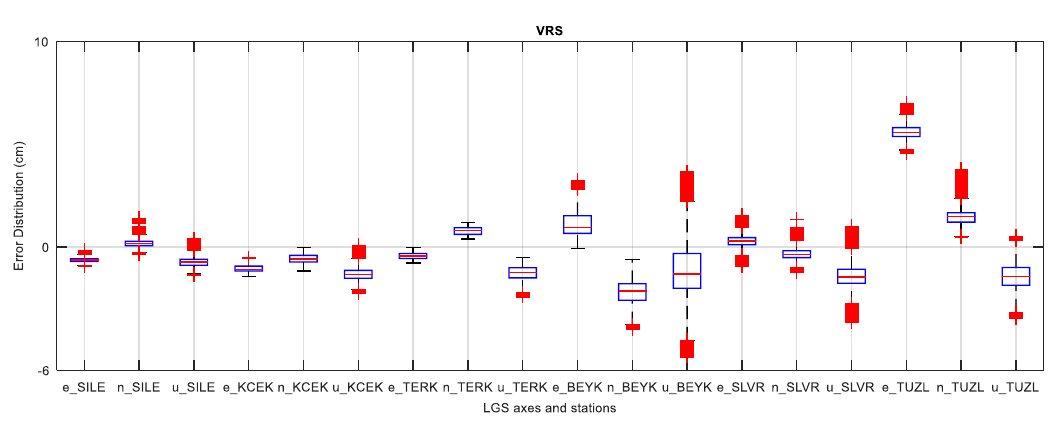
Figure 8. FKP—VRS box plot.